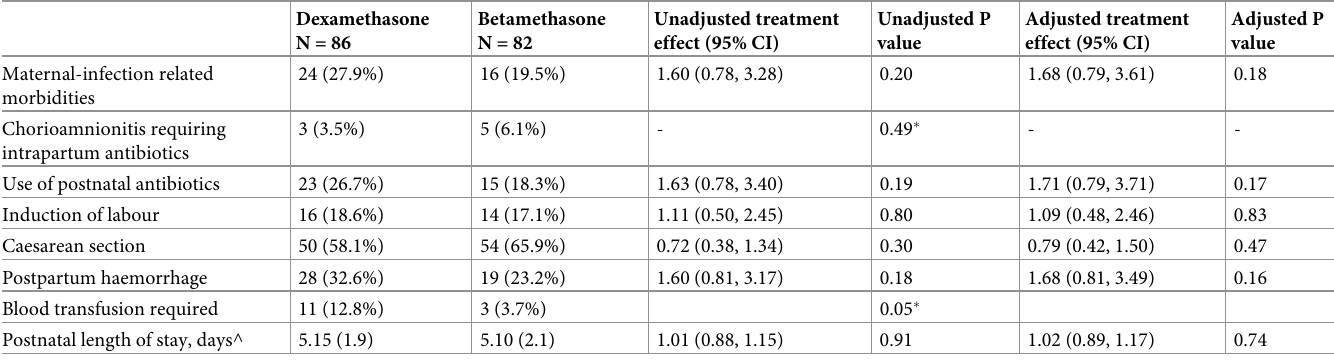
Table 4. Secondary maternal outcomes assessed before hospital discharge, after